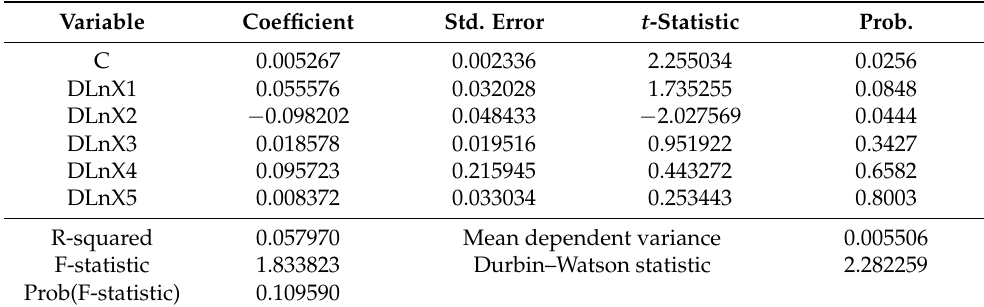
Table 1. Linear model: dependent variable: DLnY. Method: least squares. Sample (adjusted): 2007M06 to 2020M04. Included observations: 155 after